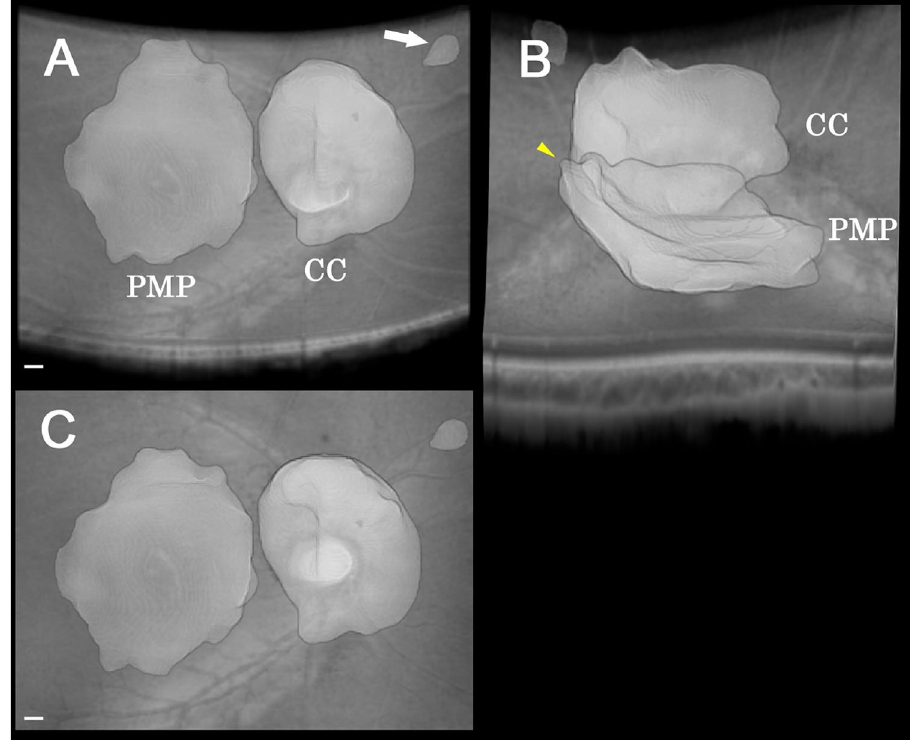
Figure 3. Three-dimensional vitreous cavity model of the right eye of a healthy 8 year-old boy. ( A) Top view image from the inferior side of the eye. Fundus shows that the premacular pocket (PMP) and Cloquet’s canal (CC) are present above the macular area and the optic disc. Threre is another small cystic cavity at the area superior nasal to the macula (white arrow). ( B) Image viewed from temporal side showing that the superior boundary of the PMP is lifted up anteriorly (yellow arrowhead). ( C) Front view image of 3D model shows that the PMP extends between the retinal vascular arcade, and the superior boundary of the PMP lies over the superior retinal arcade. The volume of the PMP is 4.1 ± 0.2 mm 3 and the surface area is 44 ± 3 mm 2 . CC is located in front of the optic disc. The volume of the CC is 5.2 ± 0.3 mm 3 and the surface area is 33 ± 2 mm 2 . The scale bar is 500 µm. Plus-minus values are the propagating error of the segmentation. PMP premacular vitreous pocket, CC Cloquet’s canal.